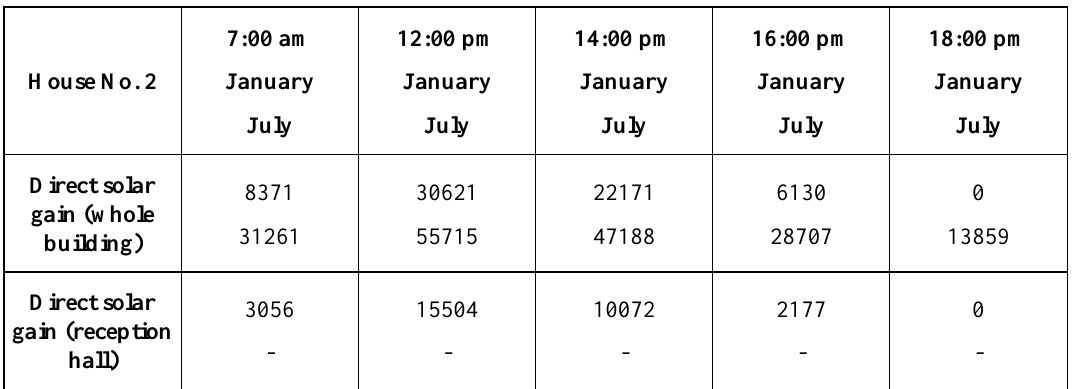
Table 6 Direct solar gain of house No.2 (unit: W.h) (Data done in Ecotect, Source: Author)